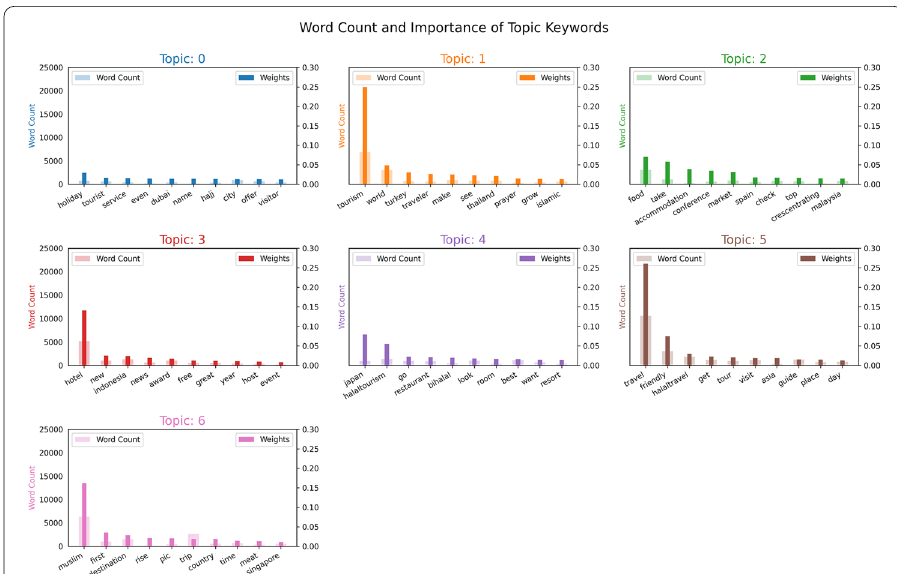
Fig. 6 Word Count and Weight of Each Word in the